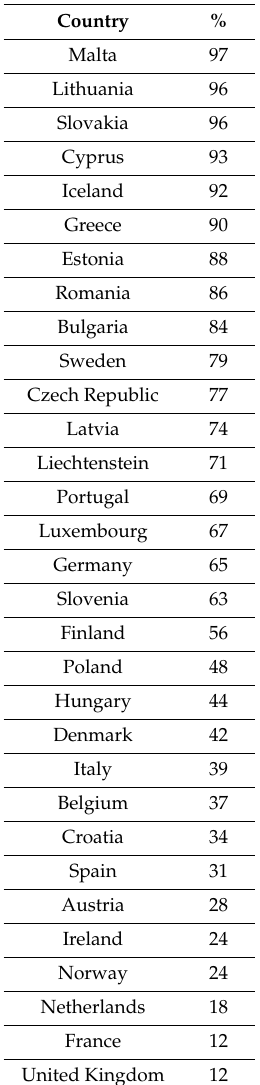
Table 1. Proportion of procedures in which the contract award was carried out only on a price criterion, 2018, %. Country